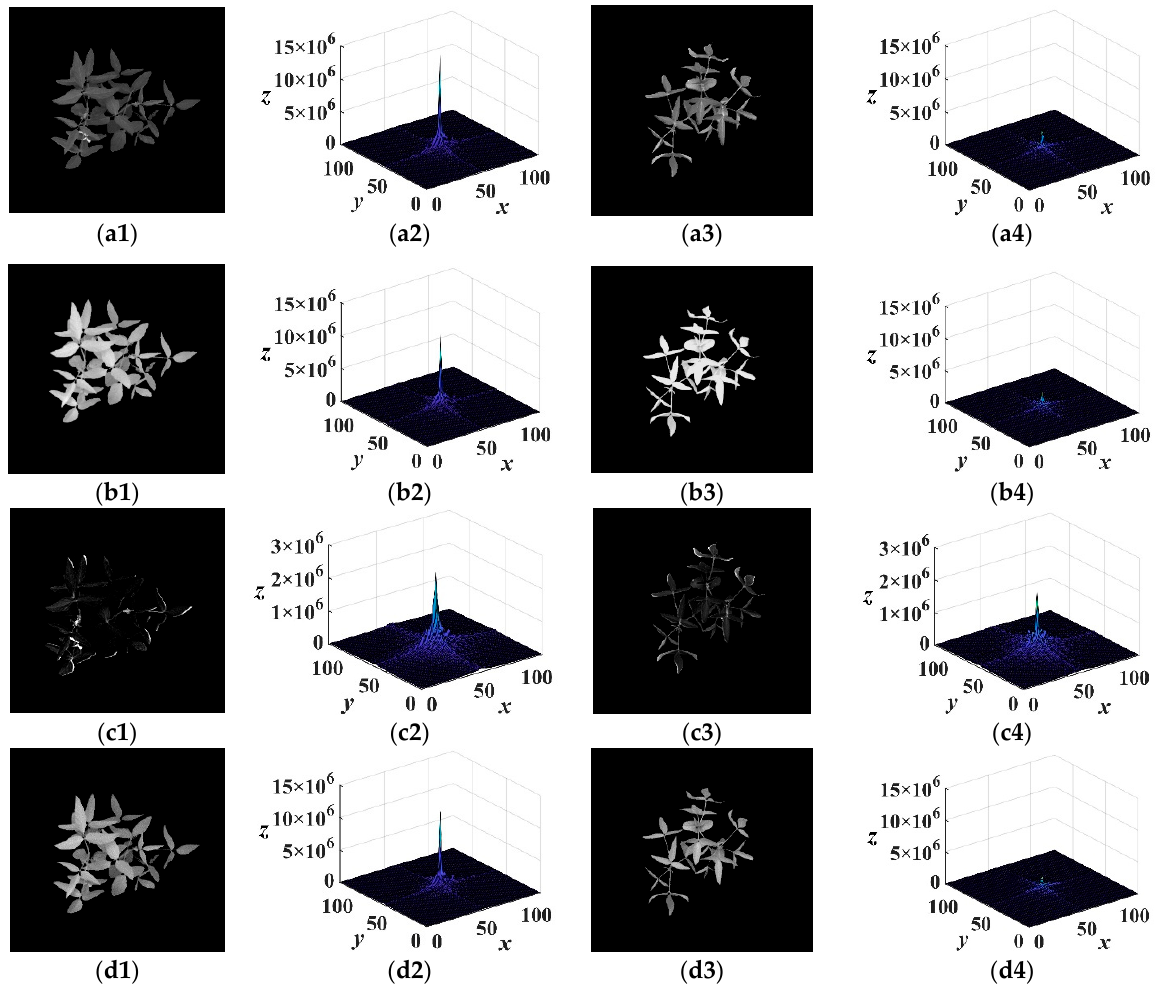
Figure 17. Soybean canopy and the corresponding spectrum: ( a1 ) GRE canopy under normal treatment, ( a2 ) GRE spectrum under normal treatment, ( a3 ) GRE canopy under drought treatment, ( a4 ) GRE spectrum under drought treatment, ( b1 ) NIR canopy under normal treatment, ( b2 ) NIR spectrum under normal treatment, ( b3 ) NIR canopy under drought treatment, ( b4 ) NIR spectrum under drought treatment, ( c1 ) RED canopy under normal treatment, ( c2 ) RED spectrum under normal